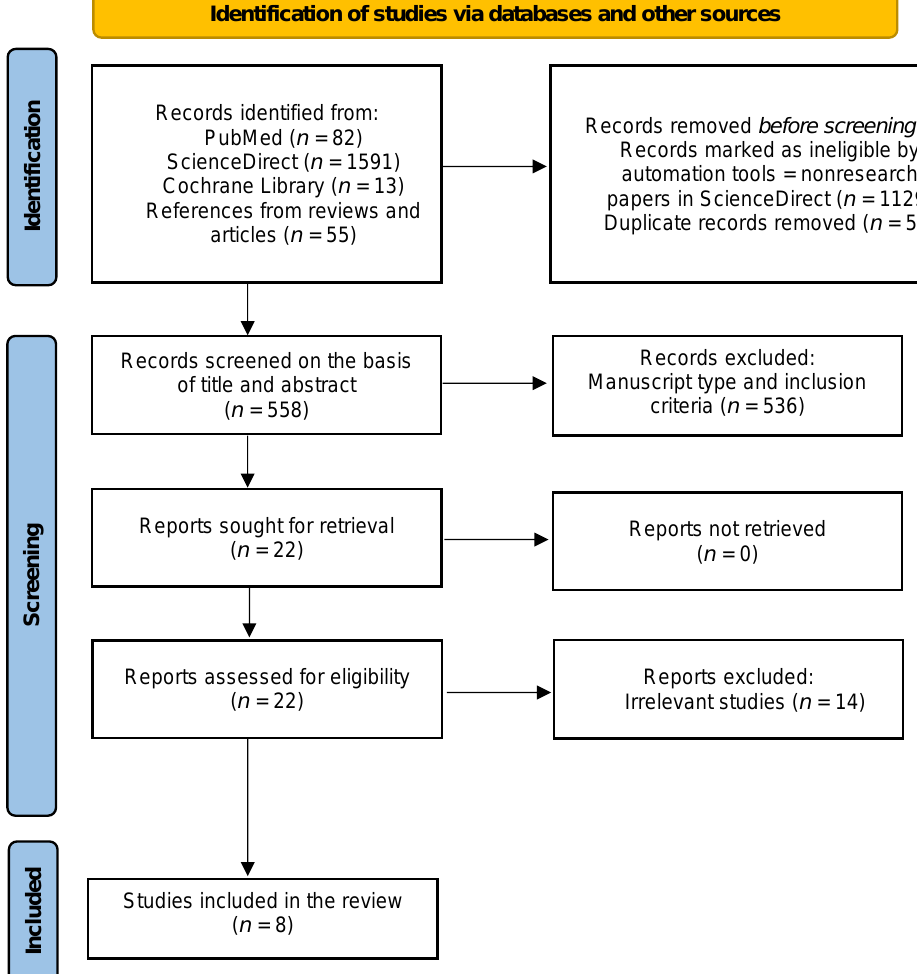
Figure 1. Schematic representation adapted from [43] of the processed followed to identify and select suitable studies according to the PRISMA